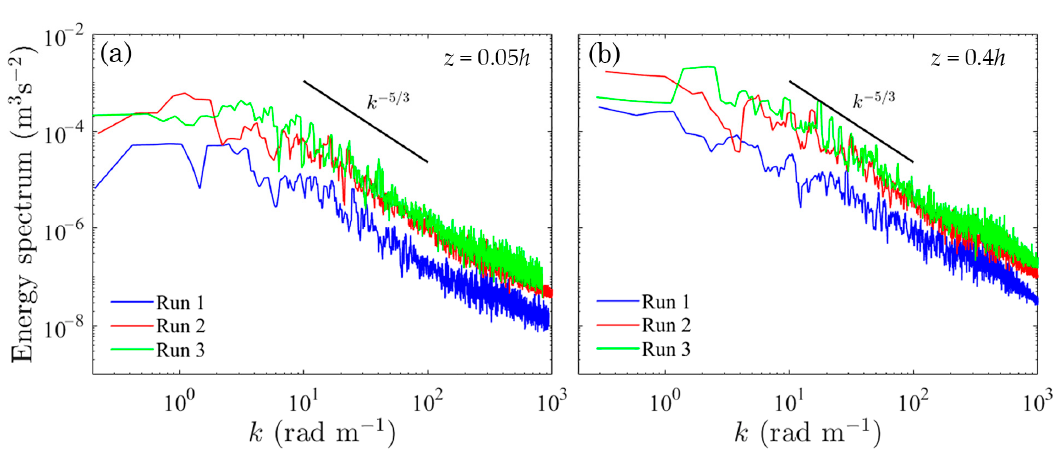
Figure 5. Energy spectra at ( a ) z = 0.05 h and ( b ) z = 0.4 h for the approaching flow in Run 1, Run 2, and Run 3. The black solid line represents Kolmogorov’s 5/3-law.